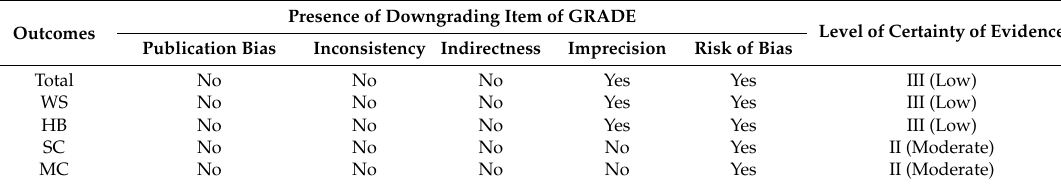
Table 4. GRADE assessment of evidence certainty for exercise e ff ects.